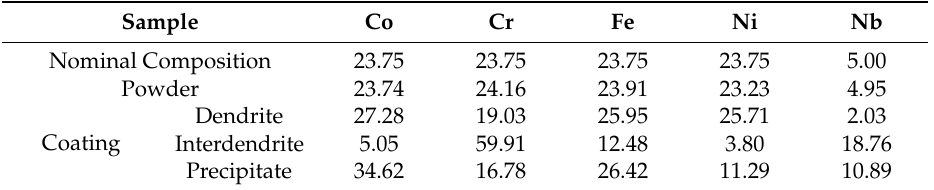
Figure 2. ( a , b ) Scanning electron microscope (SEM) images of the (CoCrFeNi) 95 Nb 5 HEA powder, ( c – g ) Chemical analysis of HEA powder by energy dispersive spectrometry (EDS). Table 1. Nominal compositions and chemical compositions of (CoCrFeNi) 95 Nb 5 HEA powder and coating